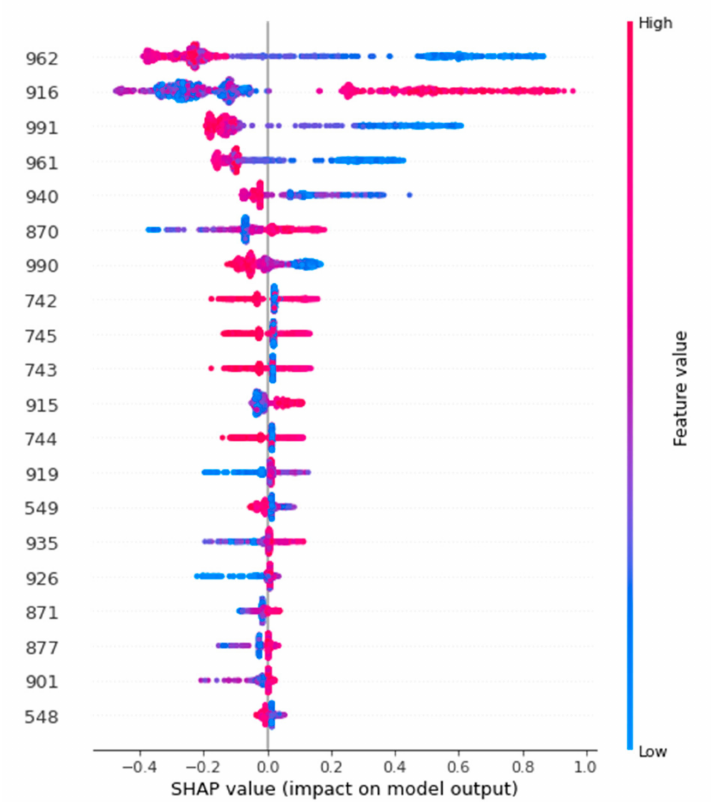
Figure 11. Shapley additive explanations (SHAP) value analysis for DMY. X-axis represents SHAP value while Y-axis represents wavelength of feature (Unit: nm). Color represents the reflection value of each